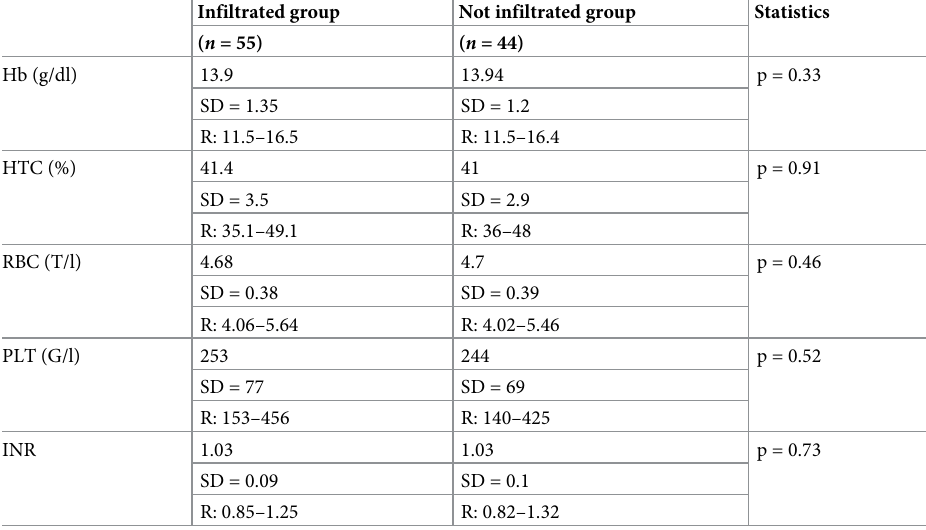
Table 2. The comparison of preoperative blood and INR results. Infiltrated group Not infiltrated